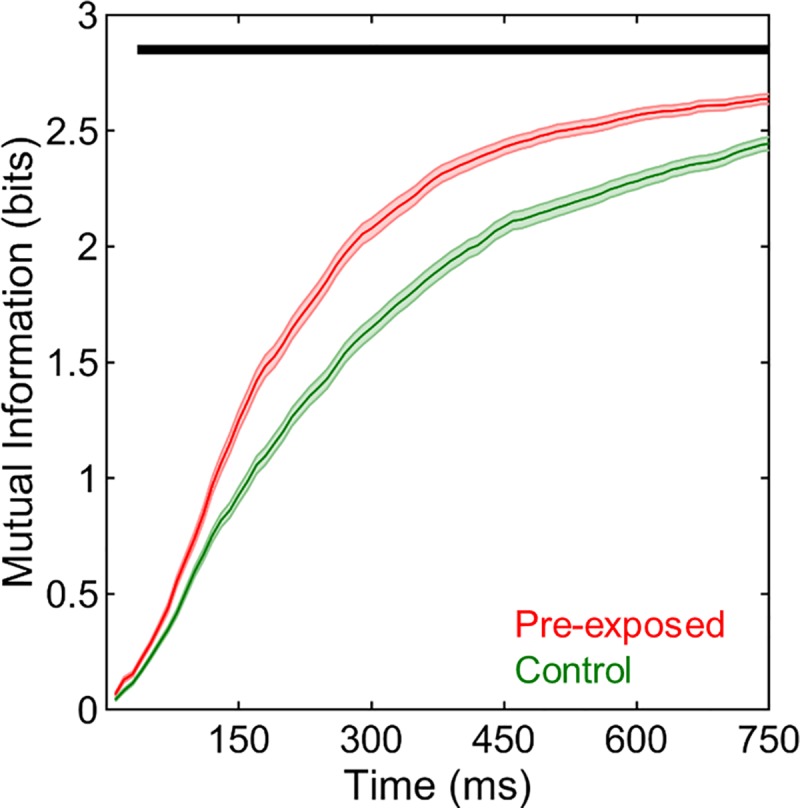
Mutual information in pre-exposed and control conditions.Mutual information was higher in the pre-exposed than in the control condition starting from the 4th time bin until the end of the stimulus period (40–750 ms). Shadings indicate SEMs. Horizontal black bar denotes significant differences.